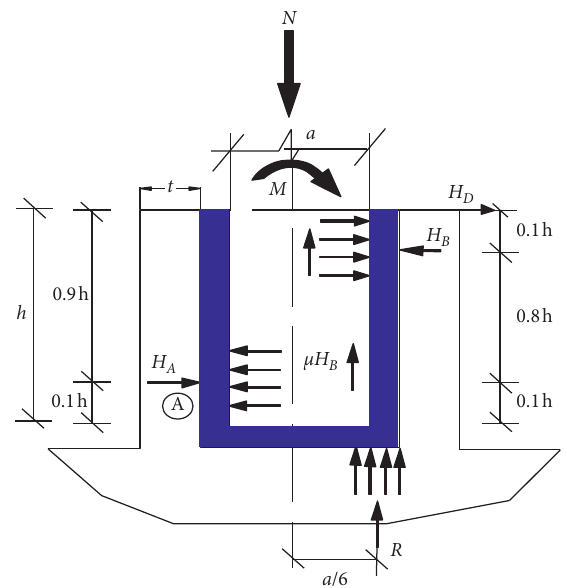
Figure 4: Distribution of forces in column